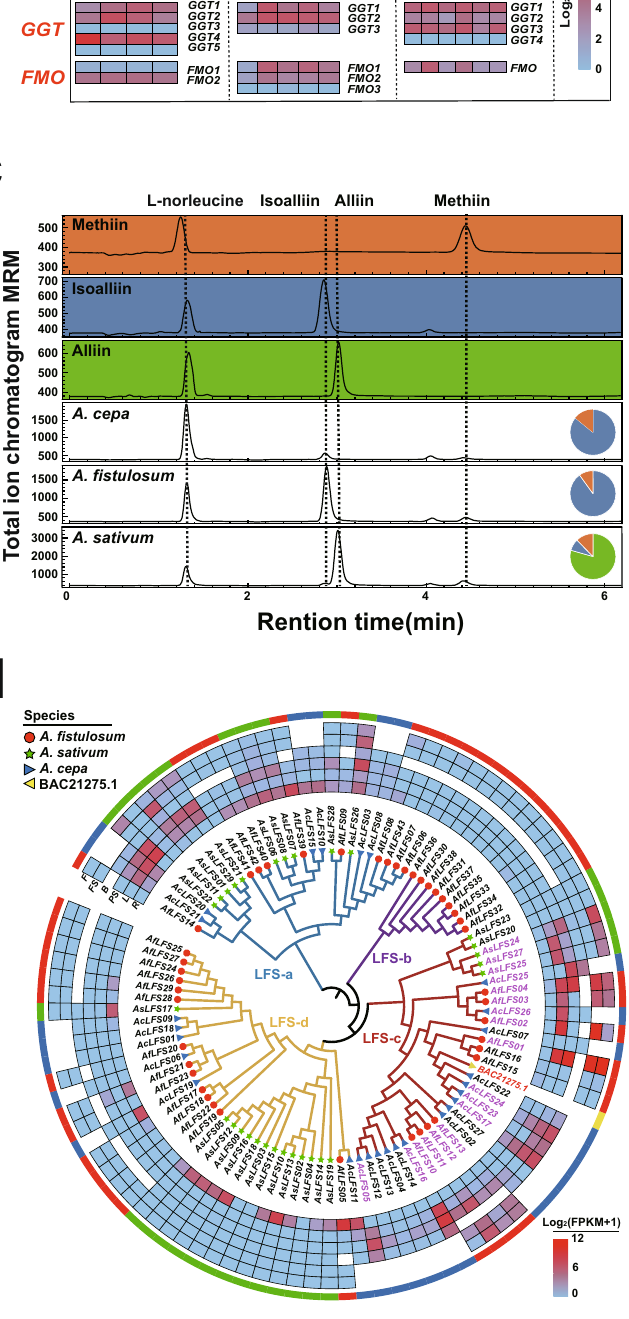
c Quanti fi cation of ACSOs among three Allium crops by ultra-high-performance liquid chromatography. The pie chart exhibited the percentages of three major ACSOs (alliin, isoalliin, and methiin). d The phylogenetic tree and the expression pattern of LFS gene families from A. fi stulosum , A. cepa , and A. sativum genomes. The outer rings highlight the genes from A. fi stulosum (red color), A. cepa (blue color),and A.sativum (greencolor).Theheatmapexhibitedthegeneexpressionsin different tissues: R roots, L leaves, PS pseudo-stems, B bulbs, FS fl oral stalks, F fl owers. Source data are provided as a Source Data fi